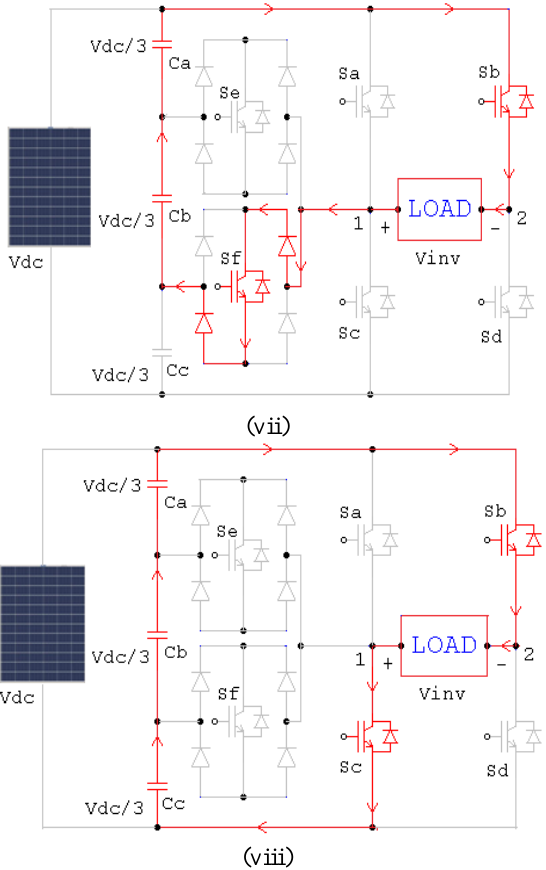
Figure 7. Switch sequence appropriate to achieve the output voltage ( 𝑉 ) (i) 𝑉 (ii) V 12 = 2V dc /3 = 𝑉 12 12 𝑑𝑐 (iii) V 12 = V dc /3 (iv) 𝑉 = 0 (v) 𝑉 = 0 ∗ 12 12 (vi) V 12 = -V dc /3 (vii) V 12 = -2V dc /3 (viii) 𝑉 = −𝑉 12 𝑑𝑐 Table 2. Output Voltage corresponding through the Switches ON-OFF mode